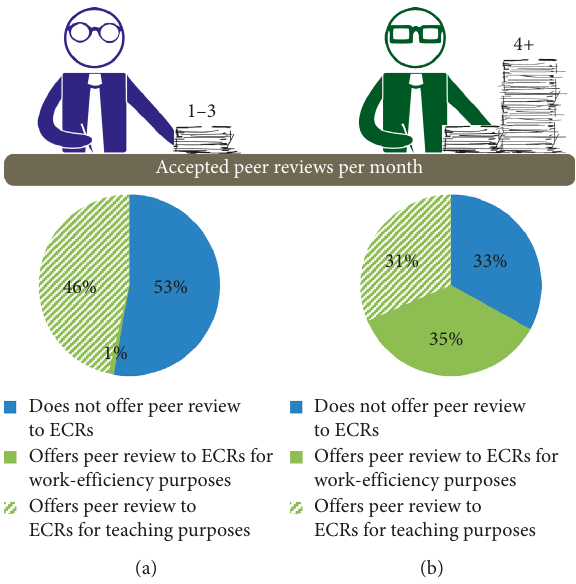
Figure 4: Statistics on academics accepting and sharing peer re- views with ECRs: percentage of academics who offered (green) and who did not offer peer review opportunities to ECRs (blue). Solid green fill signifies the percentage of respondents who offered peer review for “work-efficiency” oriented purposes, while the striped fill shows the percentage of respondents who offered peer review for “teaching” oriented purposes. Panels (a) and (b) display results for respondents who accept 1–3 and 4+ peer reviews per month,